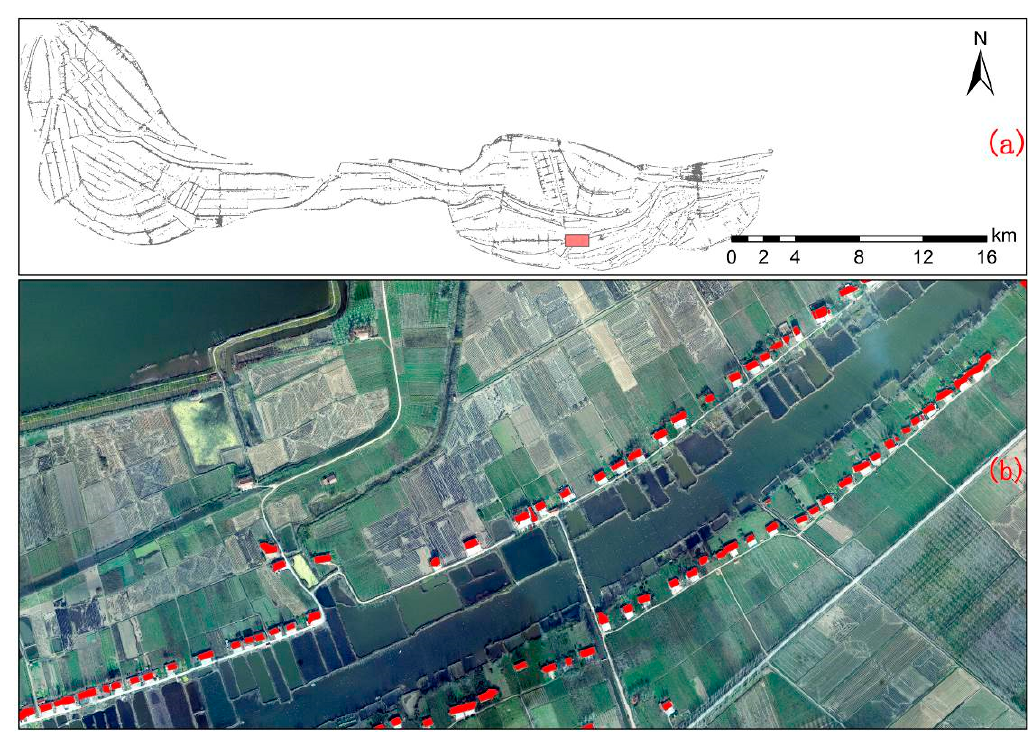
Figure 5. ( a ) Extracted building information and ( b ) detailed example (red box in ( a )).